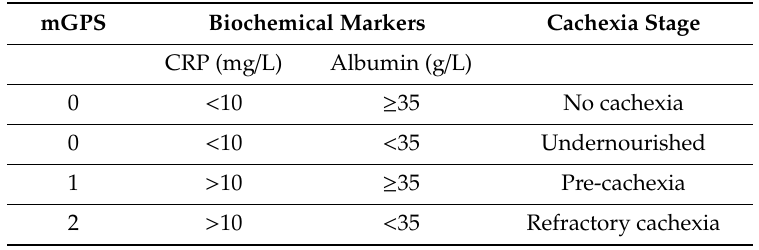
Table 1. Framework based on modified Glasgow Prognostic score